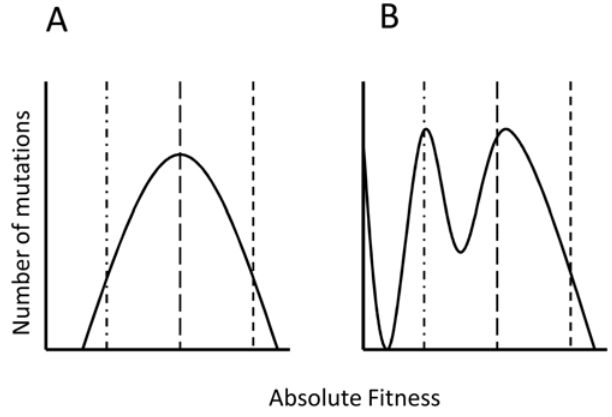
Figure 1. A schematic of the distribution of fitness effects of beneficial mutations. This figure is a schematic showing how the distribution of fitness effects of beneficial mutations can change depending on the absolute fitness of the wild type (shown with vertical lines) in two different arbitrary distributions of mutational effects on fitness. Note that the distribution of fitness effects of beneficial mutations is very similar in both of these distributions when the fitness of the wild-type is high (short dashed line).